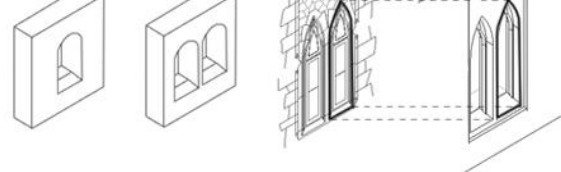
Figure 9. The basic family can be nested into a new family and duplicated in cases where an opening type consists of two arch openings. The new model can then be made to match the 2D photogrammetric survey traced data by adjusting the parameters, creating a LoD 1 model.